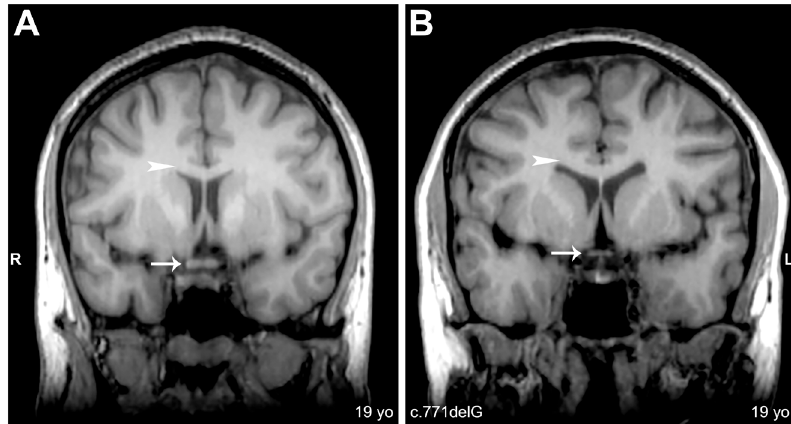
Figure 2. Optic chiasm and corpus callosum: Coronal cerebral T1-weighted magnetic resonance images, slice thickness 1.2mm. ( A ) Subject 2C: Arrow shows normal optic chiasm. ( B ) Subject 2A: Arrow shows reduced optic chiasm. Arrowheads in A and B denote normal corpus